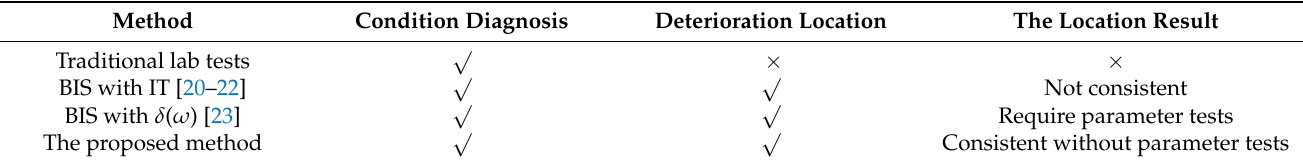
Table 4. The comparison of the condition diagnosis and location methods. Method Condition Diagnosis Deterioration Location The Location